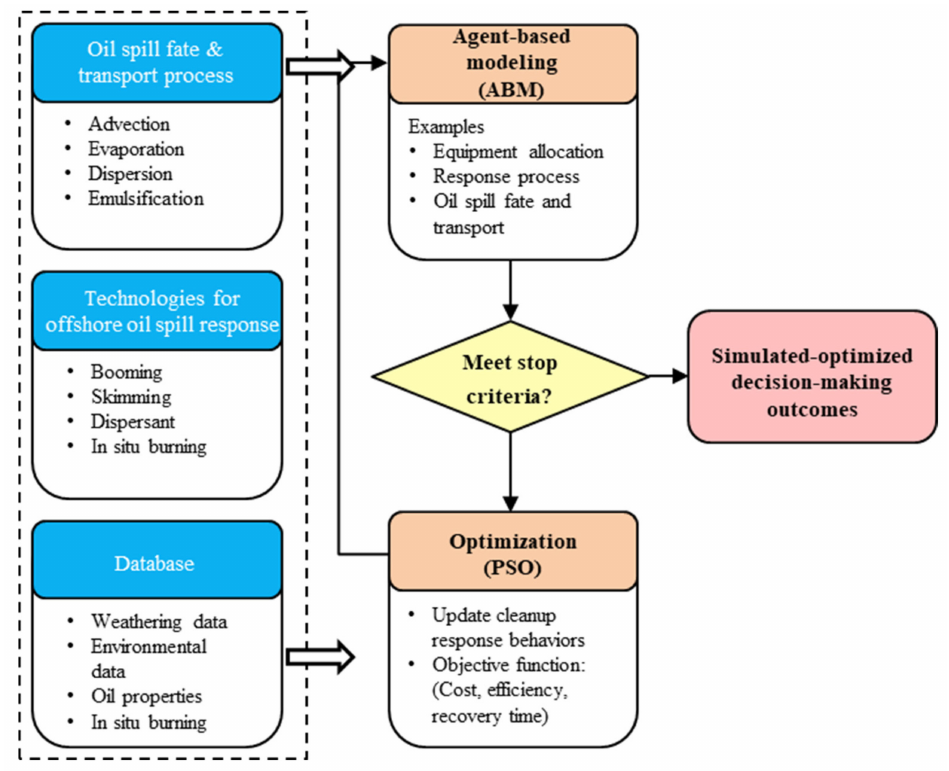
Figure 3. Framework of the simulation-based multi-agent particle swarm optimization (SA-PSO)